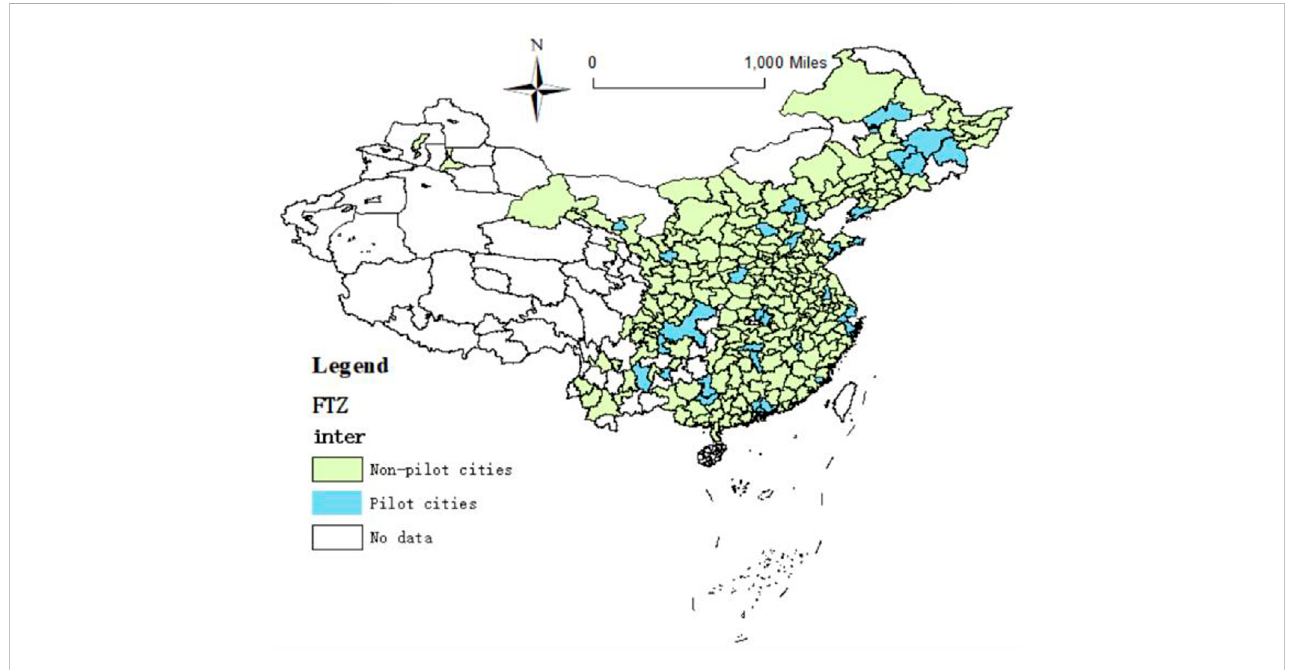
FIGURE 2 Spatial distribution of